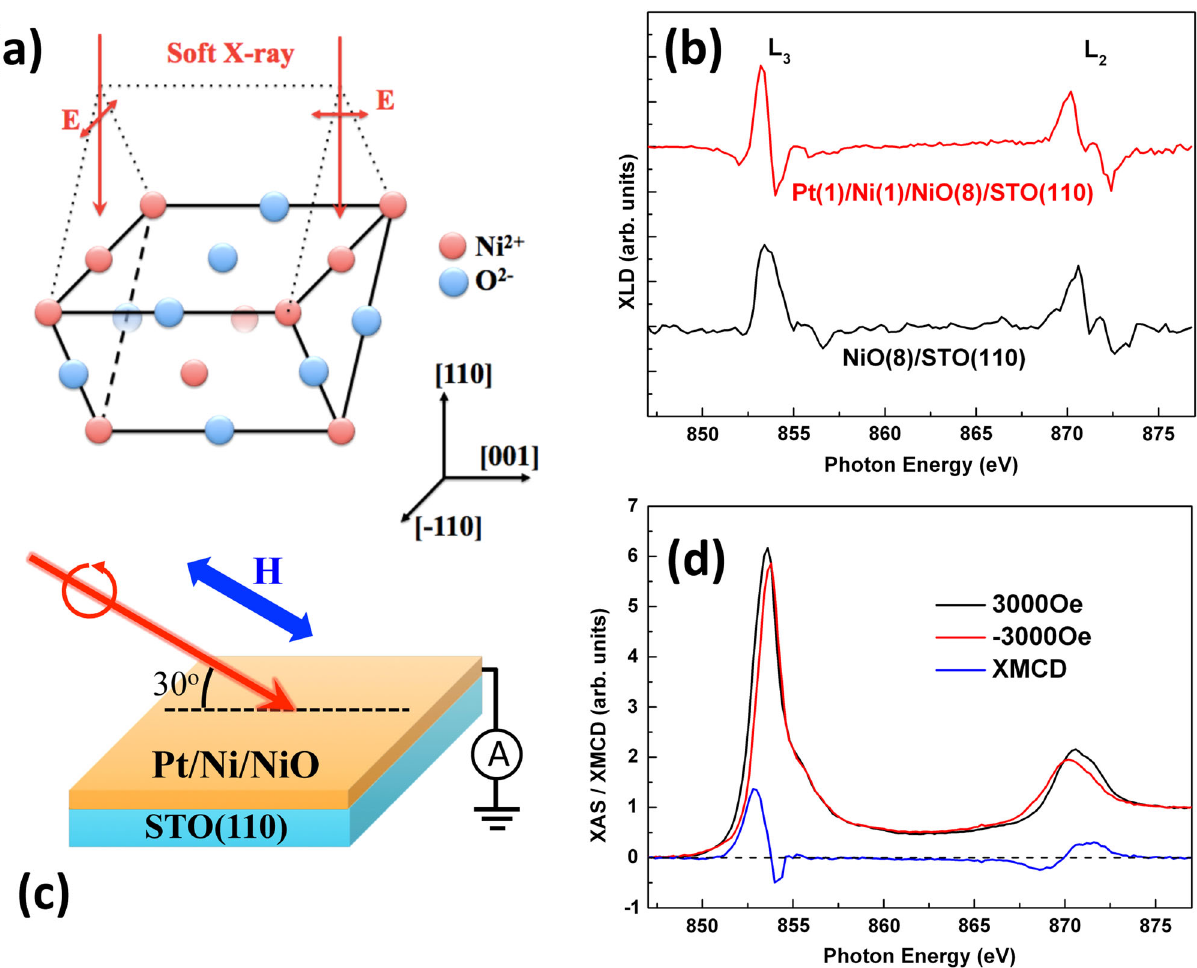
Fig. 4 Orbital preferential occupation of NiO 3 d orbital in Ni/NiO/SrTiO 3 (110) heterostructures. a The schematic of the XLD measurement shows that X-ray is perpendicularly incident and possesses different electric fi eld vectors parallel to [001] or [ − 110] directions of the substrate. Absorption of different linearly polarized X-ray corresponds to the number of empty states in orbitals parallel to [001] and [ − 110]. b XLD spectra of NiO(8 nm)/SrTiO 3 (110) and Pt(1 nm)/Ni(1 nm)/NiO(8 nm)/SrTiO 3 (110) heterostructures. c Schematic of the XMCD measurement. d Circular polarized XAS and XMCD spectra of Pt(1 nm)/Ni(1 nm)/NiO(8 nm)/SrTiO 3 (110) sample with applied ± 3000 Oe magnetic fi NiO/SrTiO 3 (110), Ni/NiO/SrTiO 3 (110) heterostructures exhibit the X-ray electric fi eld vector E parallel to [001] and [ − 110], respectively. The overall linearly polarized XAS spectra are obvious difference of XLD line shape at the L 3 edge. Considering displayed in Supplementary Fig. 6. The XLD intensity is de fi ned the polycrystalline nature of Ni layer and the much smaller as the intensity difference between the absorption of E//[001] and contribution of magnetic XLD signal in 3d ferromagnetic metals 38 , E//[ − 110] linearly polarized X-rays, namely, XLD = XAS(E//[001])- the contribution of 1 nm Ni metal layer could be reasonably XAS(E//[ − 110]). As Ni L-edge XAS spectra re fl ect the atomic neglected. Therefore, the difference of XLD signal between NiO/ 2 p 6 3 d 8 – 2 p 5 3 d 9 transition in the samples, positive XLD intensity SrTiO 3 (110) and Ni/NiO/SrTiO 3 (110) indicates preferential occupa- represents holes in the d orbital parallel to [001] and negative XLD tion of 3 d orbital parallel to [001] at the Ni/NiO interface compared intensity represents holes in the d orbital parallel to [ − 110] 36 . to the bare (110) oriented NiO. It can be seen that the L 3 XLD Considering the detection depth of the total electron yield (TEY) spectrum of NiO/SrTiO 3 (110) structure only shows a positive peak, mode in the XLD measurement 37 , thinner metal layers are and that of Ni/NiO/SrTiO 3 (110) structure shows two overlapped necessary for detecting the signal of NiO layer at the interface, positive and negative peaks, which indicates a combination of as detailedly discussed in Supplementary Note 6. Although in our occupation in both orbitals parallel to [001] and [ − 110]. Therefore, sample, the 1 nm Ni layer is not thick enough for us to detect the the Ni metal deposition can induce preferential occupation in the magnetic anisotropy directly due to its weak magnetization, it orbitals parallel to [001]. As for the L 2 edge, the difference would be suf fi cient to extract information about the chemical between NiO/SrTiO 3 (110) and Ni/NiO/SrTiO 3 (110) is not signi fi cant, bonding and the orbital reconstruction at the interface. The XLD but there is still similar character as the L 3 edge, which is probably spectra of the NiO(8 nm)/SrTiO 3 (110) and Pt(1 nm)/Ni(1 nm)/NiO(8 because the Ni 2 p 1/2 core-level (L 2 edge) wave function is more nm)/SrTiO 3 (110) heterostructures are displayed in Fig. 4b. The XLD isotropic than the Ni 2 p 3/2 (L 3 edge). To explore the evidence that signal of NiO/SrTiO 3 (110) structure could re fl ect the preferential the uniaxial anisotropy in Ni layer is connected to the preferential occupation of Ni 3 d orbitals in NiO, XMCD measurement was orbital occupancy of the (110)-oriented NiO thin fi lm, which could performed for the Ni/NiO/SrTiO 3 sample as well. The circularly be induced by the nonrelaxed substrate strain or possible texture of Ni ionic magnetic moments. As compared to the XLD signal of polarized soft X-ray was utilized and ±3000 Oe magnetic fi eld was